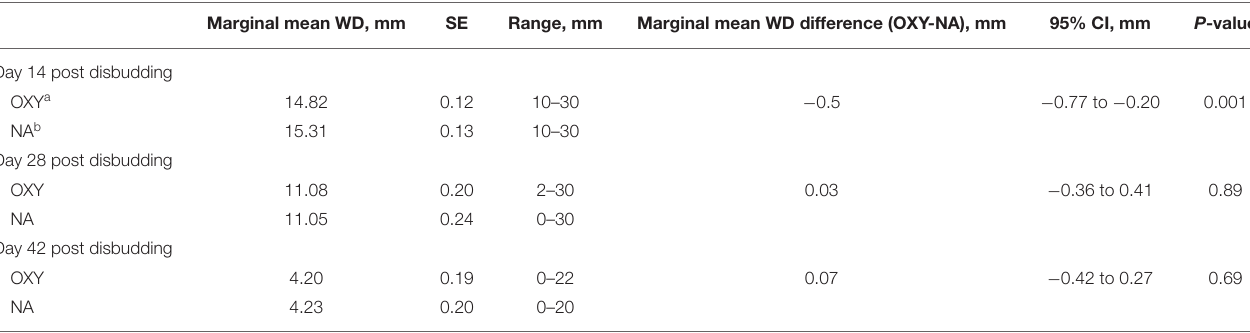
TABLE 2 | Linear regression analysis on the paired difference wound diameter (WD) with farm as fixed